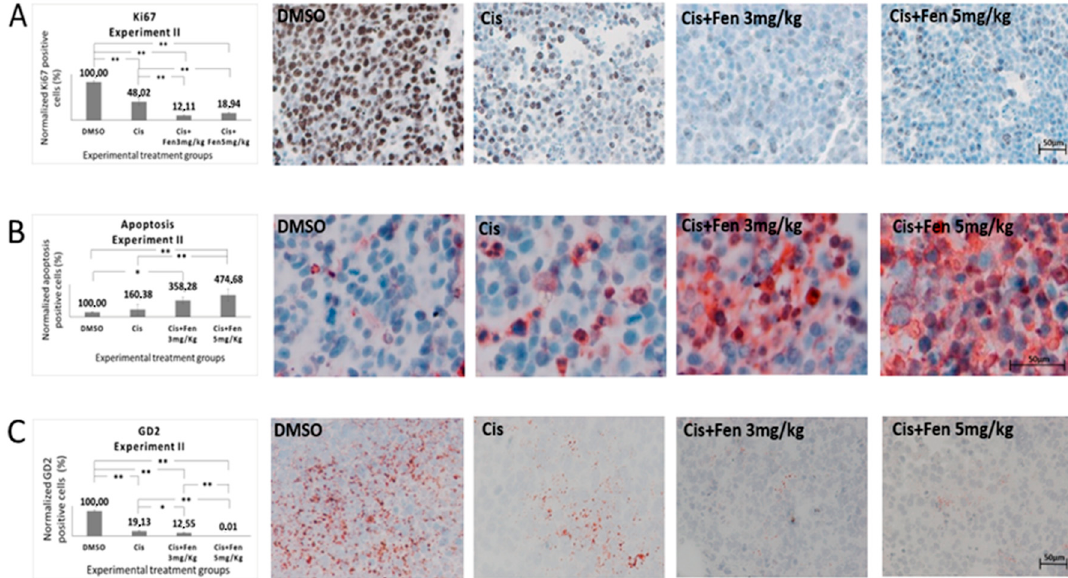
Figure 4. Fendiline hydrochloride in co-administration with cisplatin induces apoptosis and reduces GD2 + NB cells. Representative bright-field microscopy imaging of stained sections from subcutaneous tumors in treated and untreated mice. Panel ( A ) shows how the combined therapy reduces the expression of the cell proliferation marker Ki67 in tumors from treated mice. Panel ( B ) shows how the combined therapy increases apoptotic cell rate in tumor tissues. Panel ( C ) show GD2 immunopositive tissues. GD2 was used as NB tumor aggressiveness marker showing a positive correlation with the concentration of fendiline used. Values are reported as the mean ± SD. * indicates p ≤ 0.05, ** indicates p ≤ 0.01; one-way ANOVA with post-hoc Tukey HSD were applied. Scale bar: 50 µ